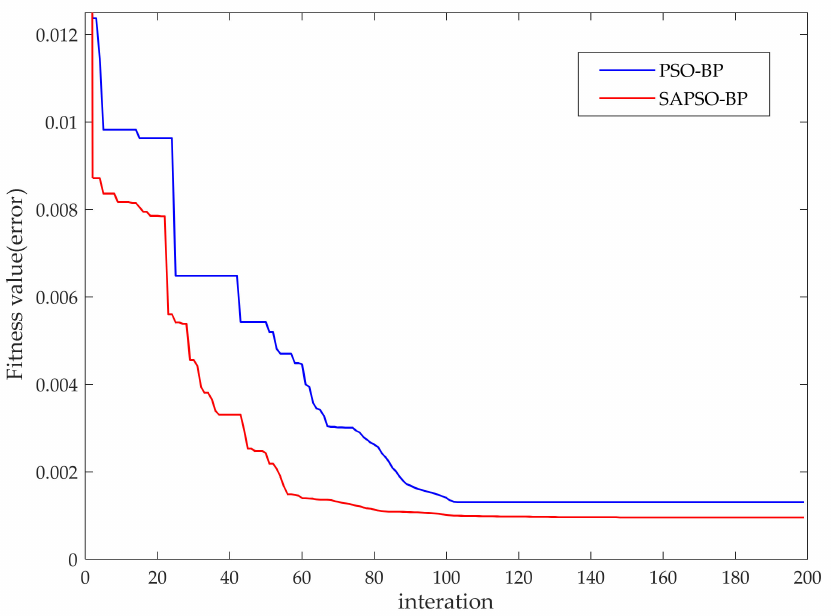
Figure 7. Comparison of convergence curves of the PSO-BP and SAPSO-BP